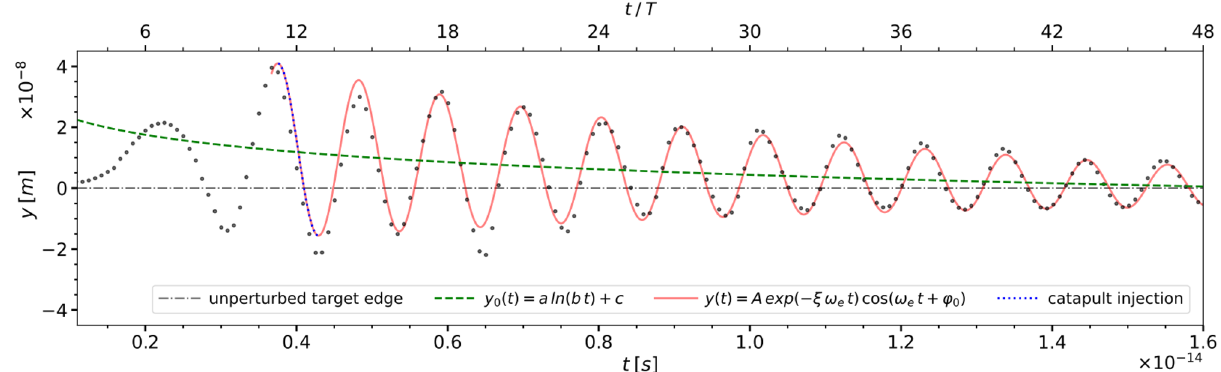
Figure 3. The electron plasma at the left edge of the multilayer graphene target executes a damped longitudinal oscillation along the y axis with a mean y 0 (dashed green line), which converges logarithmically to the initial plasma edge boundary (grey dash-dotted line). The relative elongation (black dots) is fitted with a damped oscillator model (red solid line). Injection starts at t / T = 11.25 when the plasma edge recedes leftwards and